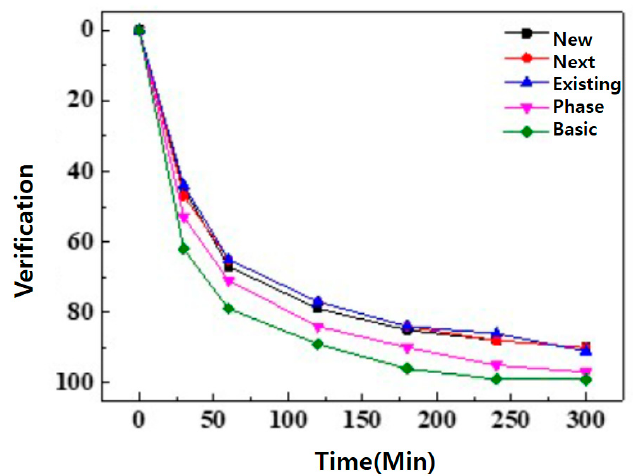
Figure 13. The difference from the existing method.